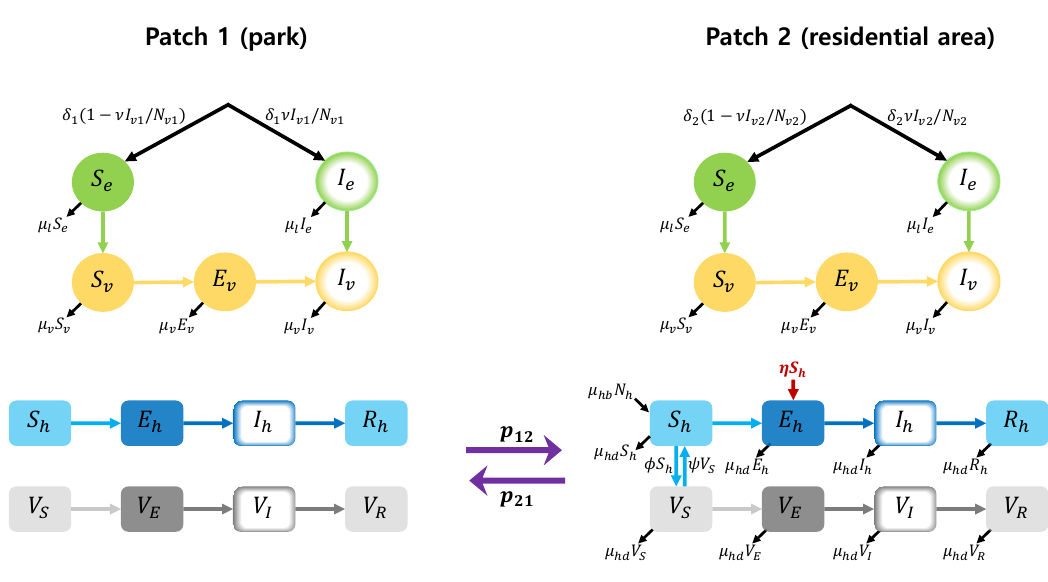
Figure 10. Two-patch dengue transmission model with